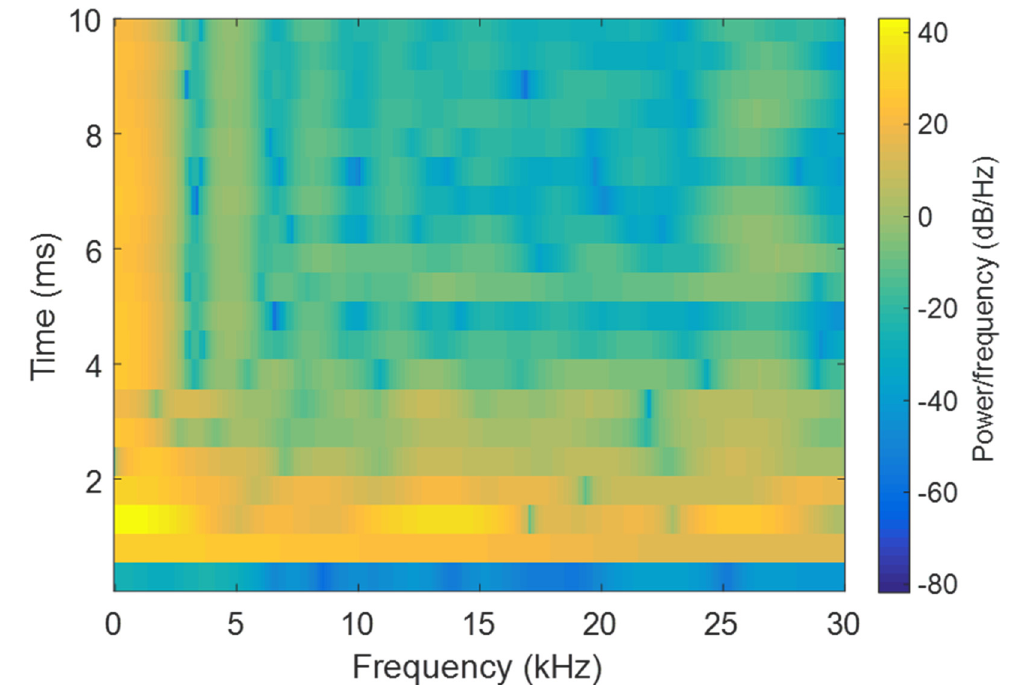
Figure 7. The STFT results of shock load signal.